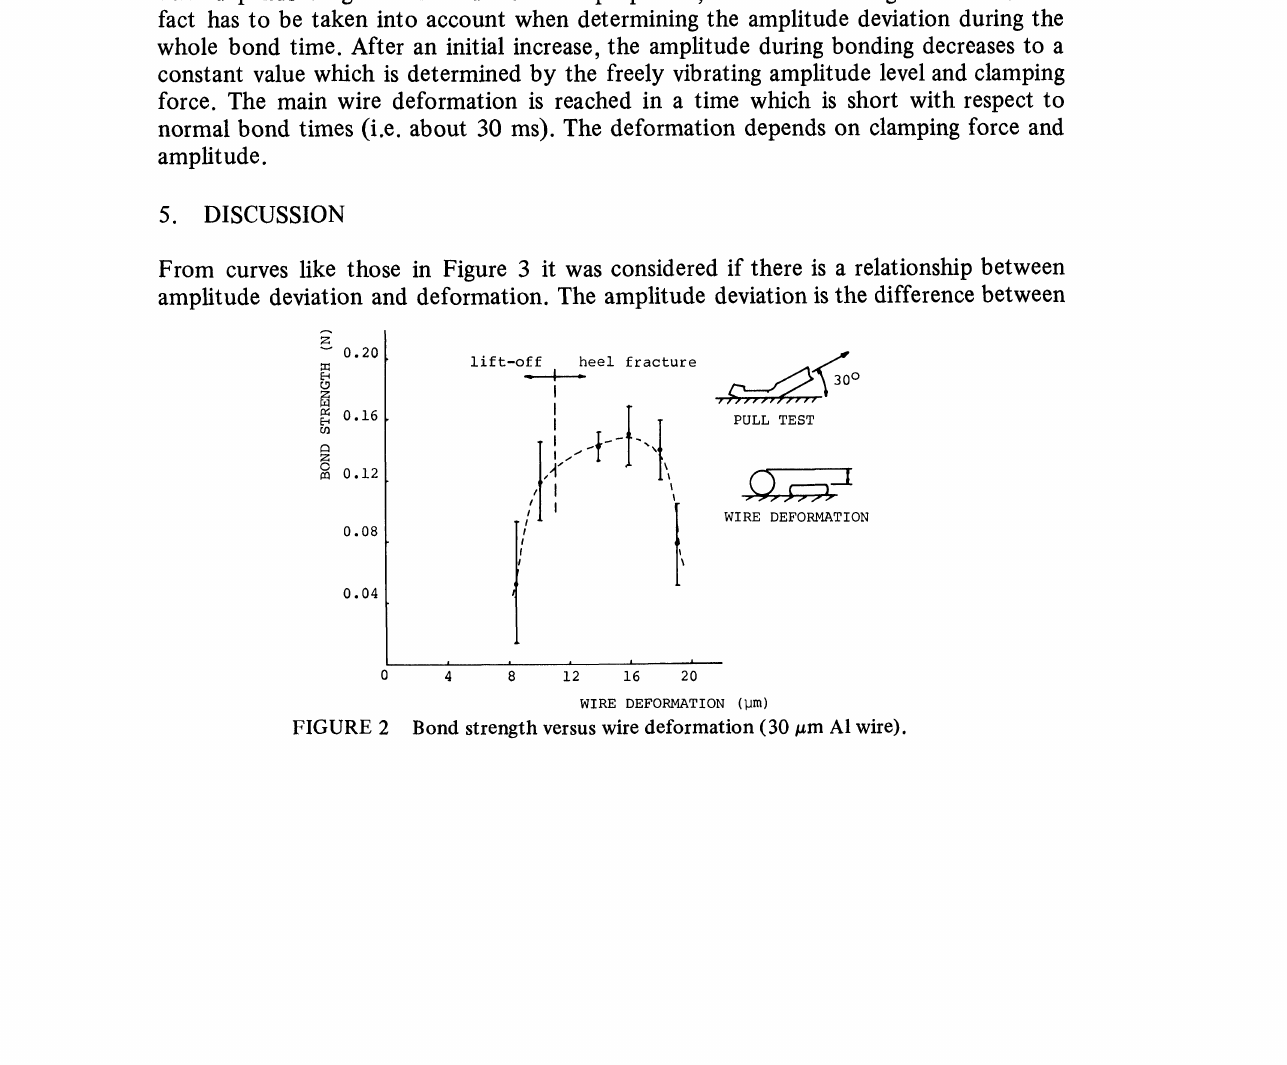
12 16 20 WIRE DEFORMATION (pm) FIGURE 2 Bond strength versus wire deformation (30 #m A1